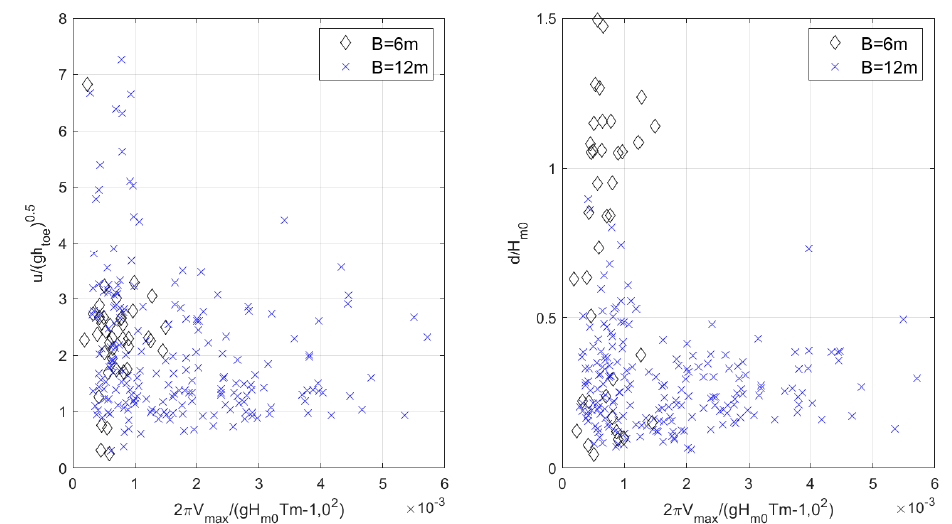
Figure 15. Variation of dimensionless overtopping layer velocity and depth with dimensionless maximum individual overtopping volume for two different promenade width.